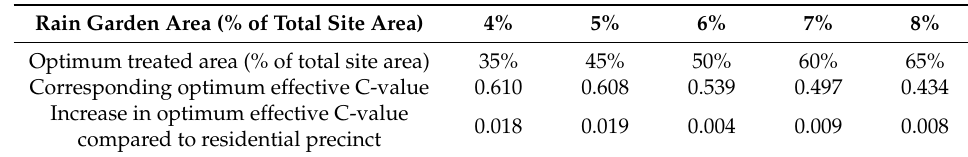
Table A9. Commercial precinct results of optimum treated areas and C-values for various rain garden sizes. Rain Garden Area (% of Total Site Area)